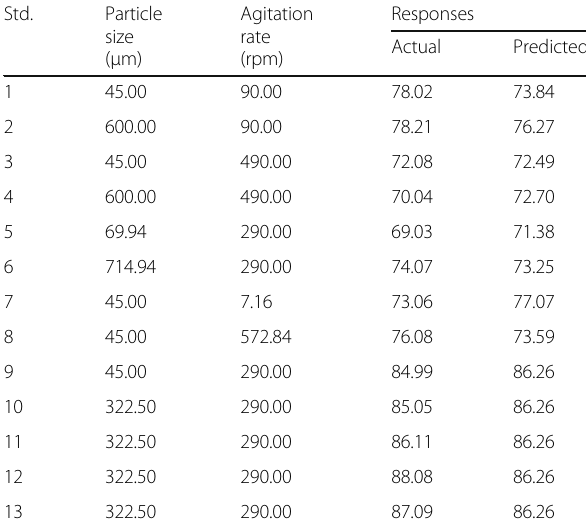
Table 2 Experimental design matrix with responses Std.